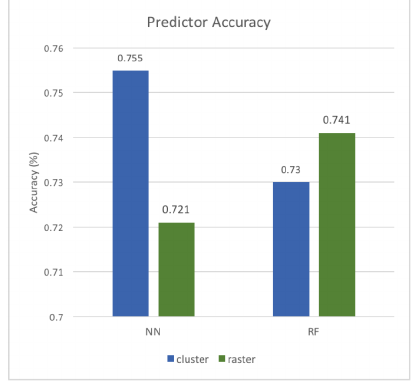
Figure 2. The accuracies of all the baseline models as well as the neural network and random forest predictor models taking into account all